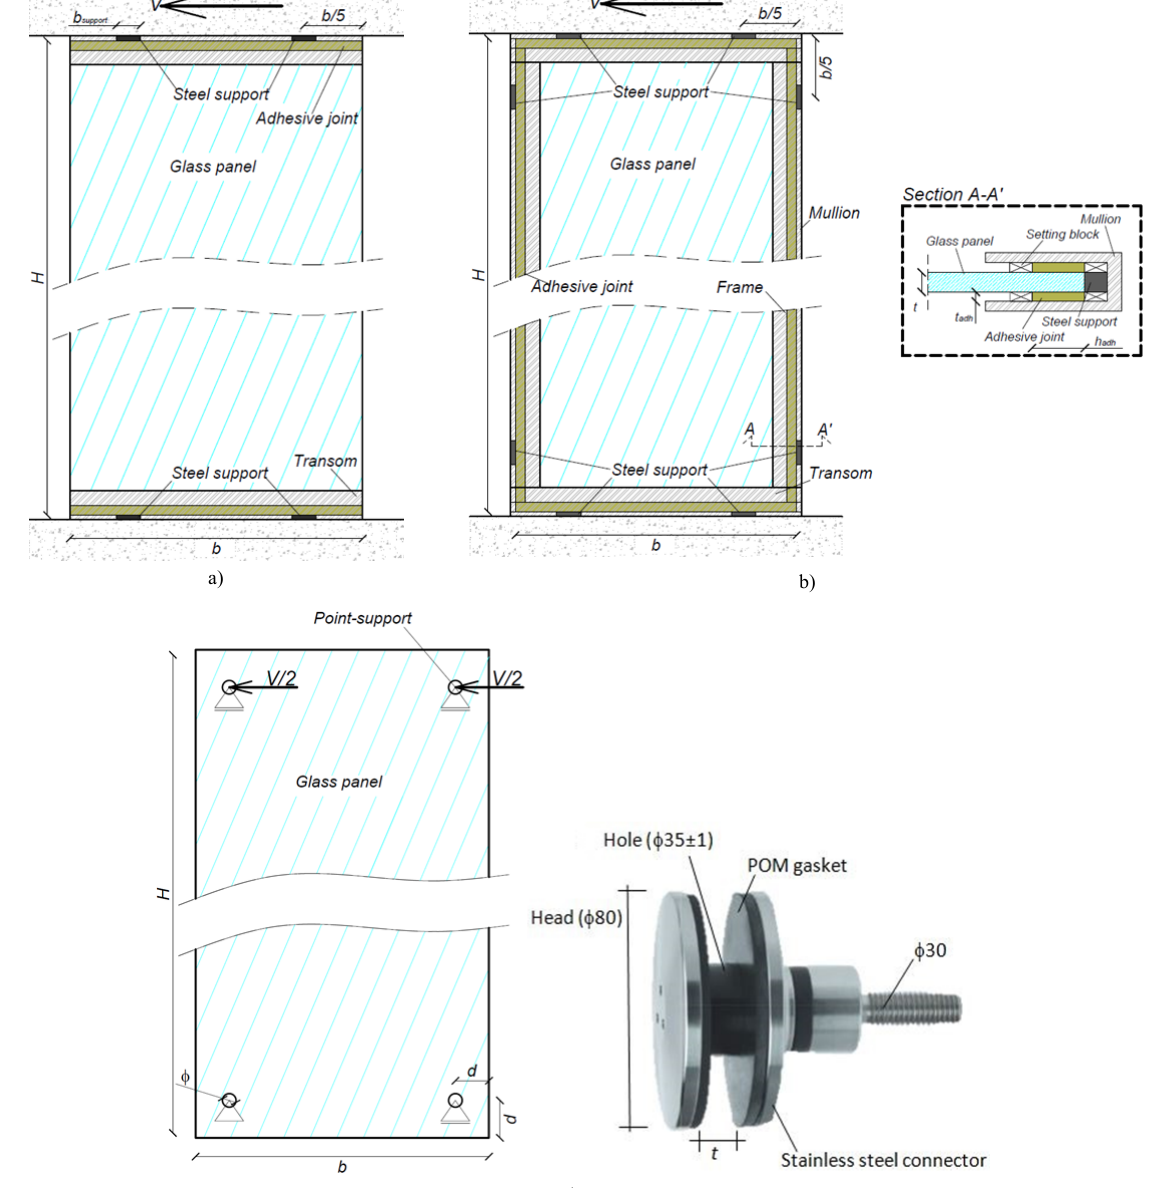
Fig. 2 Reference practical cases for the shear buckling assessment of glass walls. a) Linear adhesive joints, b) metal frame with interposed adhesive joints and b) point mechanical